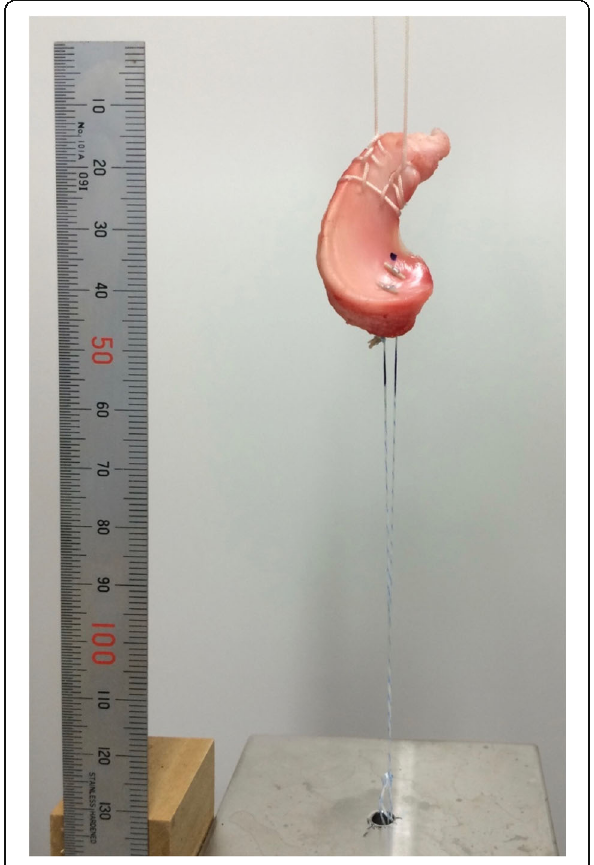
image analysis, the reference point was fixed at 10 mm below the meniscus edge at the display of the software and we measured the distance from the reference point to a small dot marked 3 mm anteriorly to the suture or anchor (Fig. 3). The displacement caused by a loading force of 5 N was defined as the difference between the distance measured at the first cycle and the distance measured at the last cycle. Additionally, the ultimate failure load and the mode of failure were recorded.